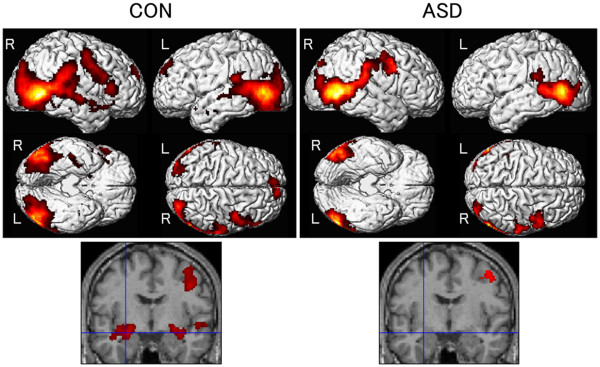
Statistical parametric maps showing significant brain activation for dynamic versus static facial expressions. The control (CON) and autism spectrum disorders (ASD) groups are shown in the left and right panels, respectively. The areas of activation are rendered on spatially normalized brains (upper) and overlaid on the normalized anatomical MRI of one of the participants at the coronal section showing amygdala activation (lower). The cross hairs in the lower panels are centered on the activation focus of the left amygdala in the control group (x -26, y -6, z -16; t = 4.65; cluster size = 5368 mm3). An extent threshold of p < .05, corrected for multiple comparisons, with a height threshold of p < .01 (uncorrected) were used. L = Left hemisphere; R = Right hemisphere.